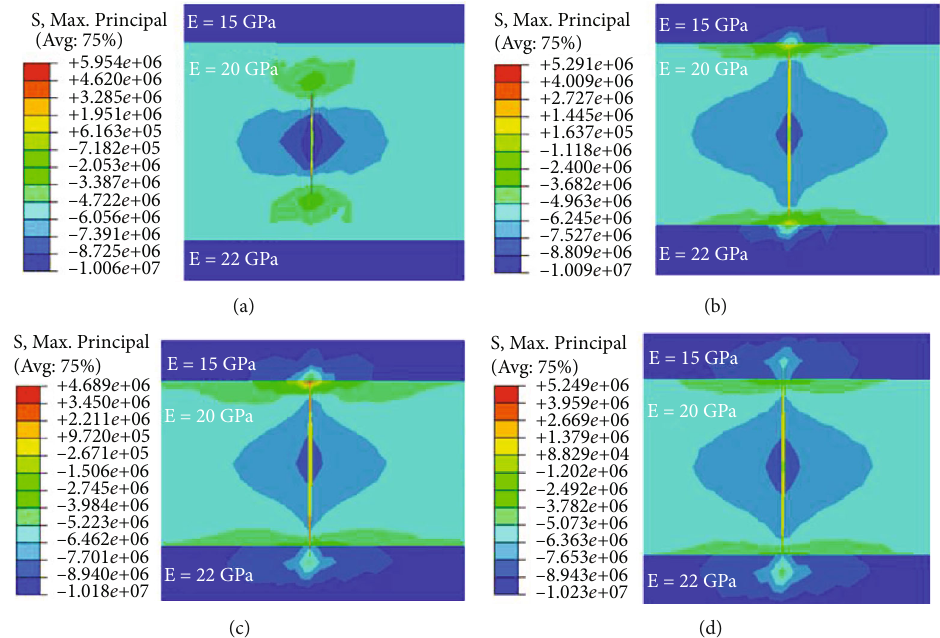
Figure 13: E ff ect of Young ’ s modulus on the development of hydraulic fracture ’ s height in case 1 at di ff erent times: (a) 10 steps, (b) 20 steps, (c) 40 steps, and (d) 50